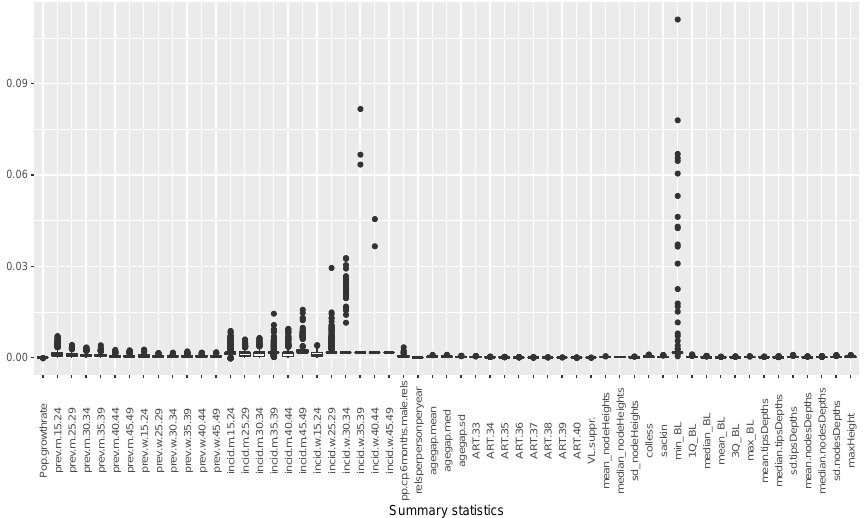
Figure A4. Relative error between mean values of a combination of epi-behavioural and the phyloge- netic tree’s summary features and those associated to retained parameter values during